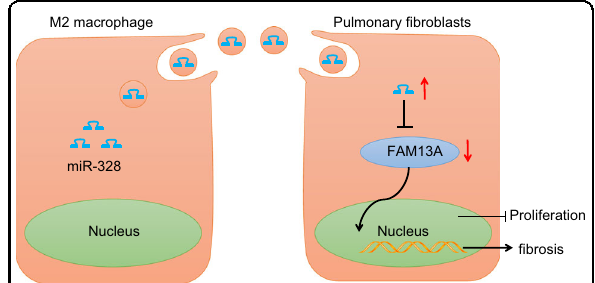
Fig. 9 Exosomal miR-328 in M2 macrophages regulates PF progression via FAM13A. miR-328 exhibited upregulated expression in rats with PF and was carried by M2 macrophage-derived exosomes. M2 macrophage-derived exosomes with silenced miR-328 conferred resistance to pulmonary interstitial fi broblast proliferation and inhibited PF by directly upregulating FAM13A